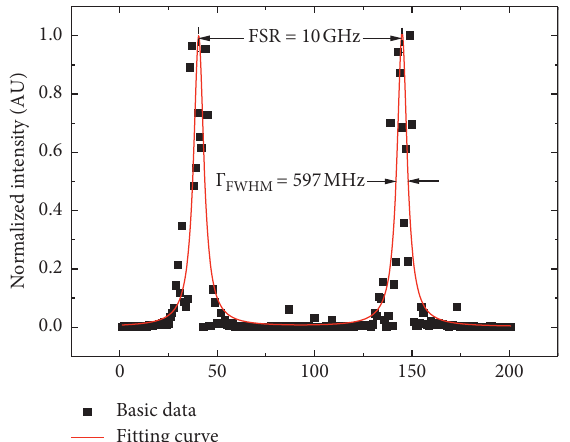
Figure 4: The spectrum of the passively Q -switched laser measured by the scanning F-P interferometer technique. FSR is the free spectral range of the etalon and Γ FWHM is the laser line